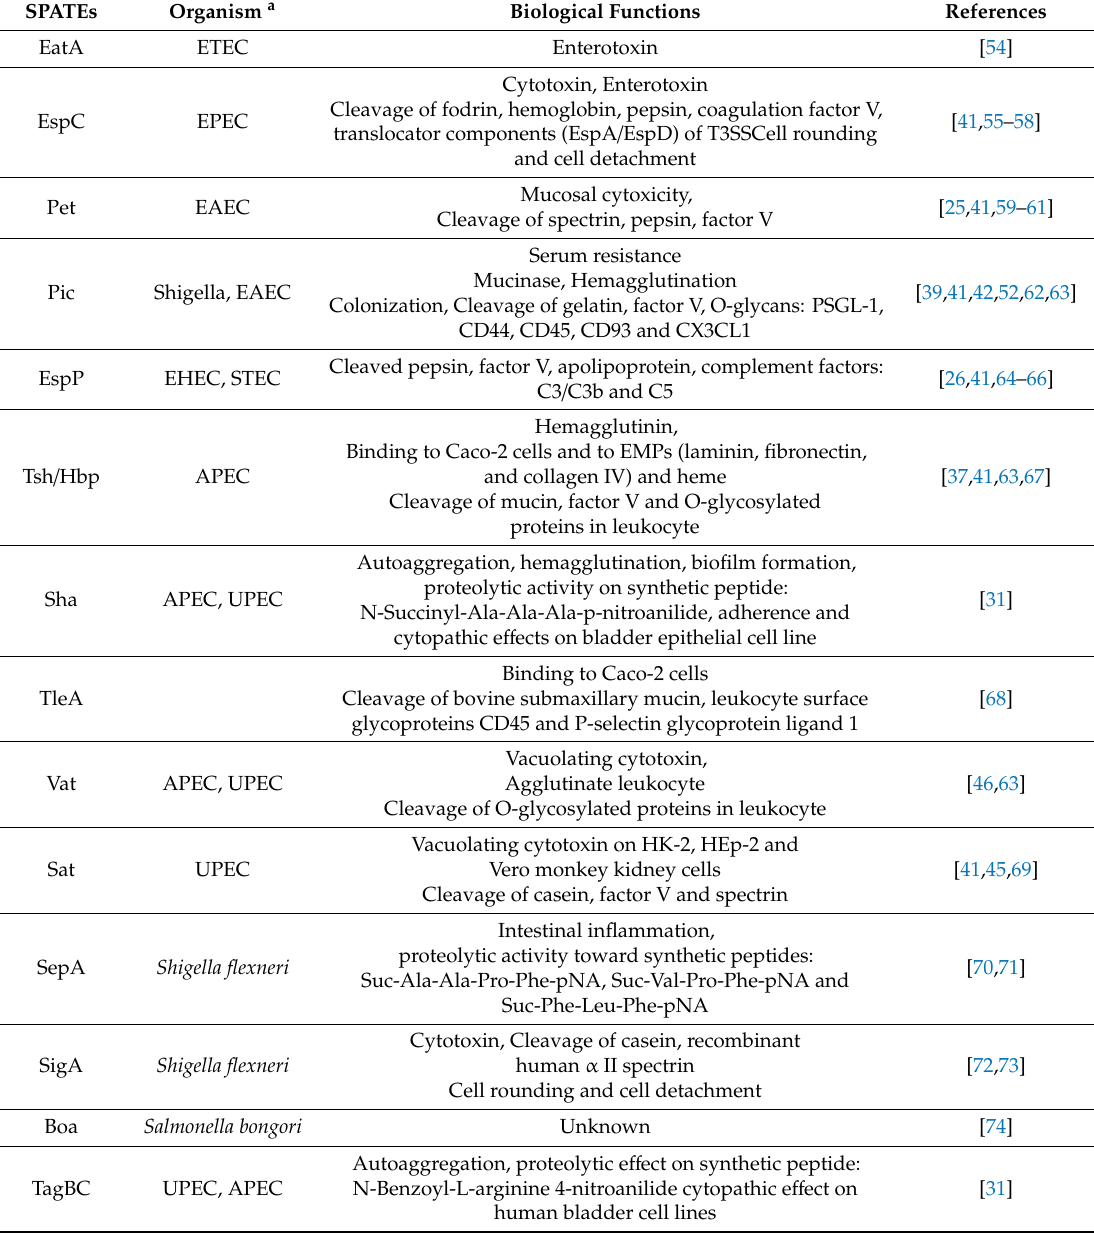
Table 1. Summary of characteristics of di ff erent